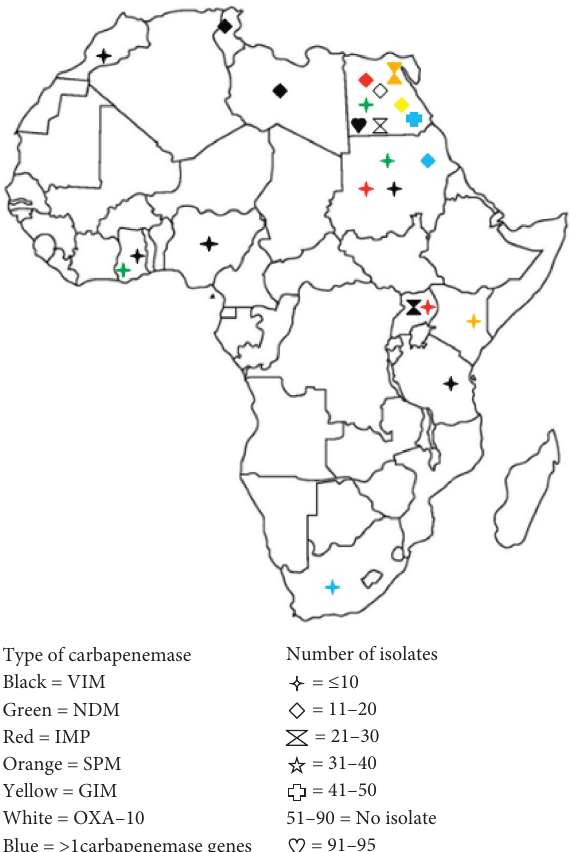
Figure 2: Geographical distribution CPPA isolates in Africa from 2007 to 2018